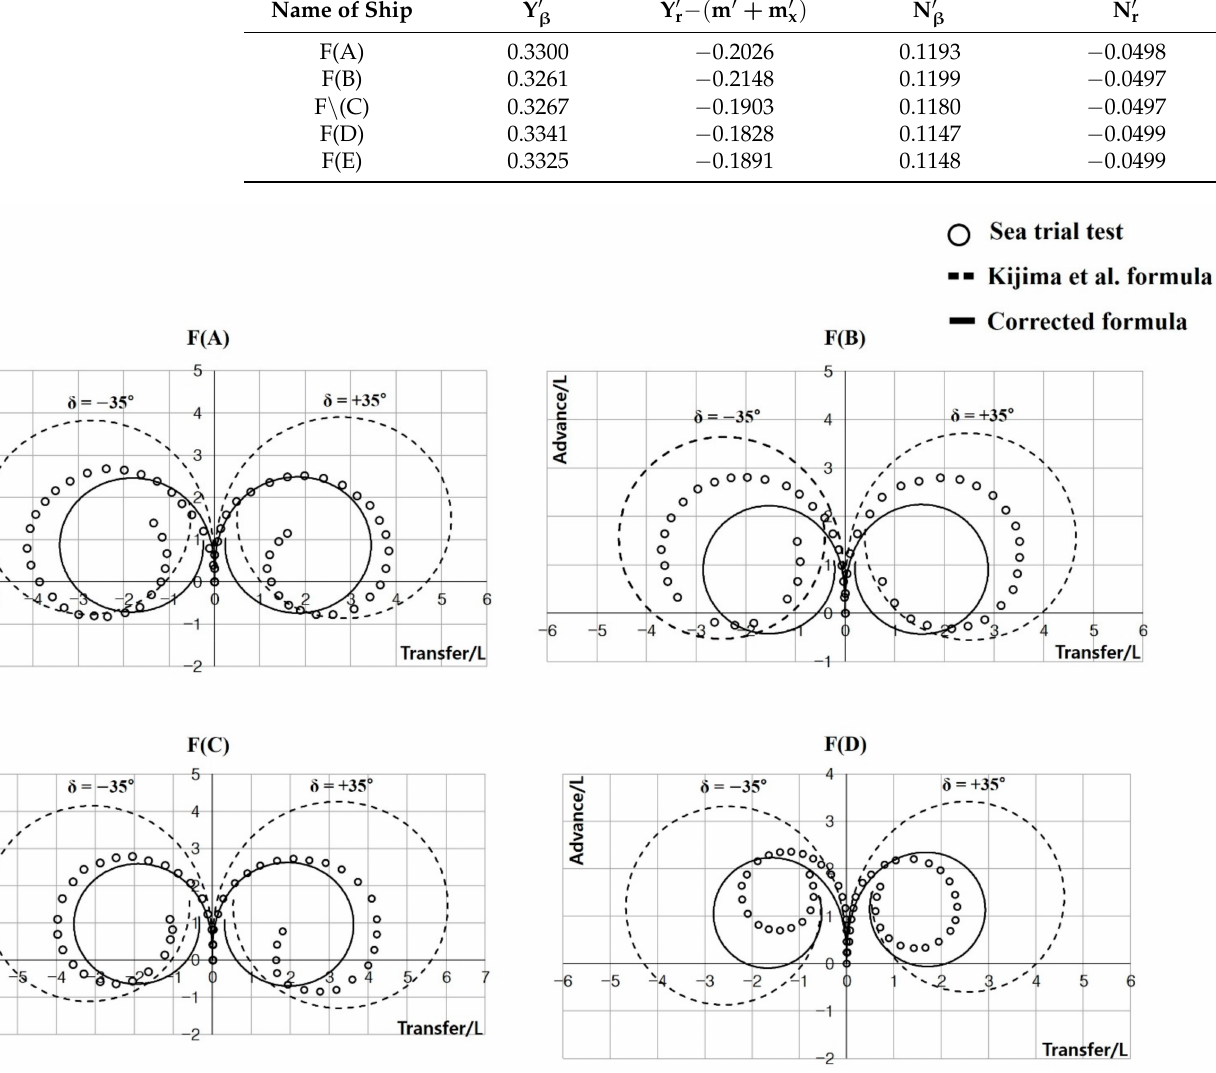
Figure 5. Comparison of turning movement test results in model fishing